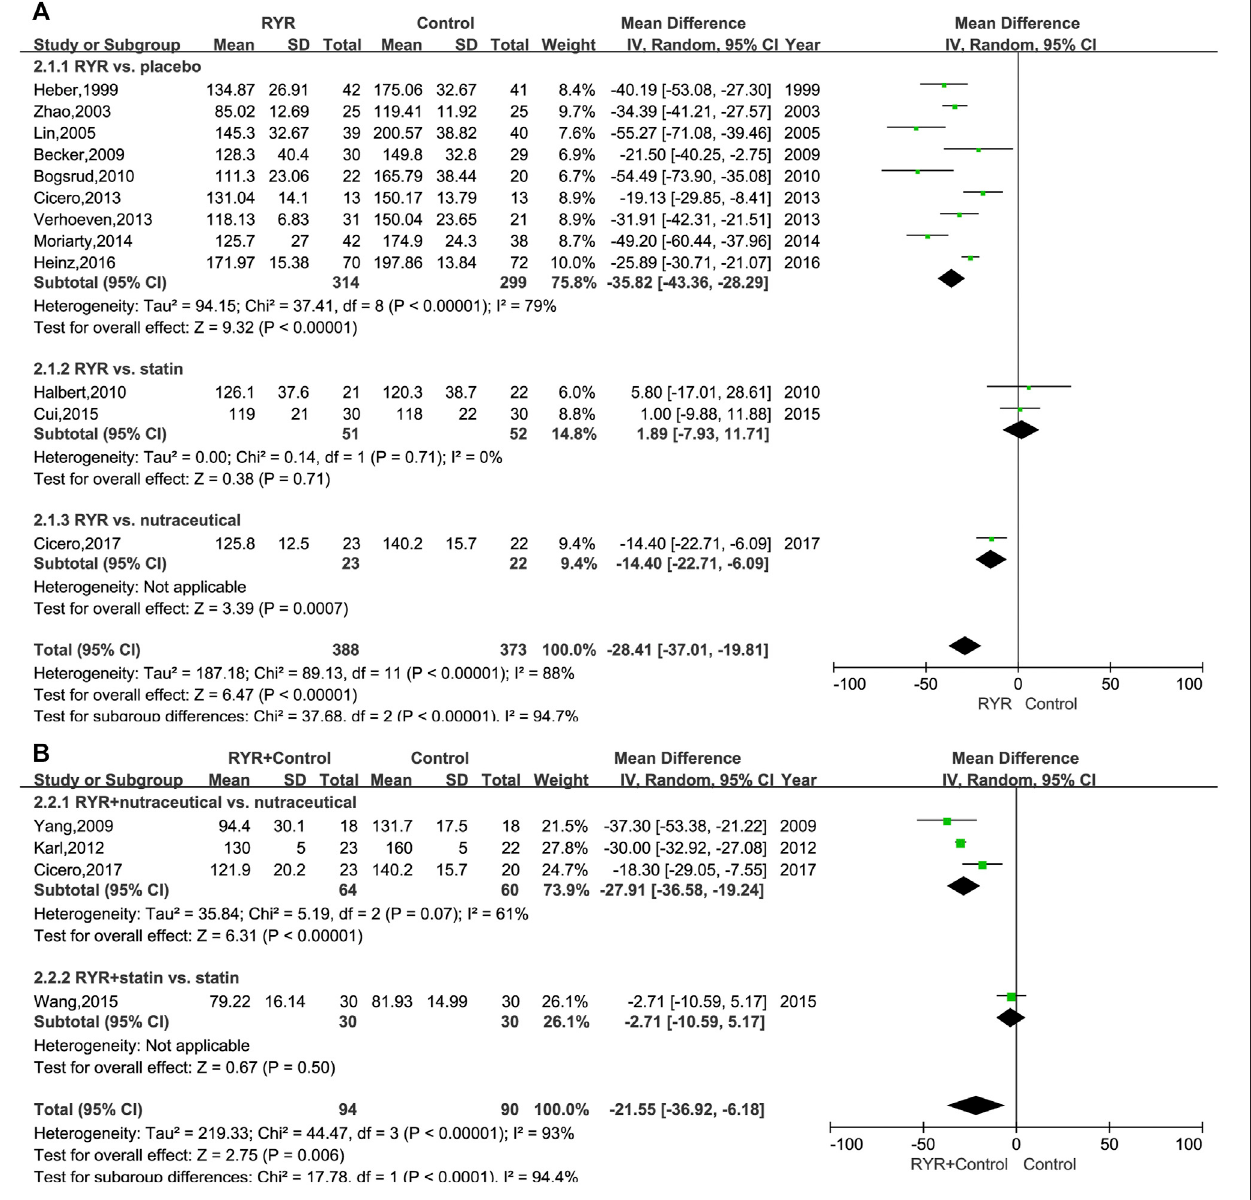
Frontiers in Pharmacology |